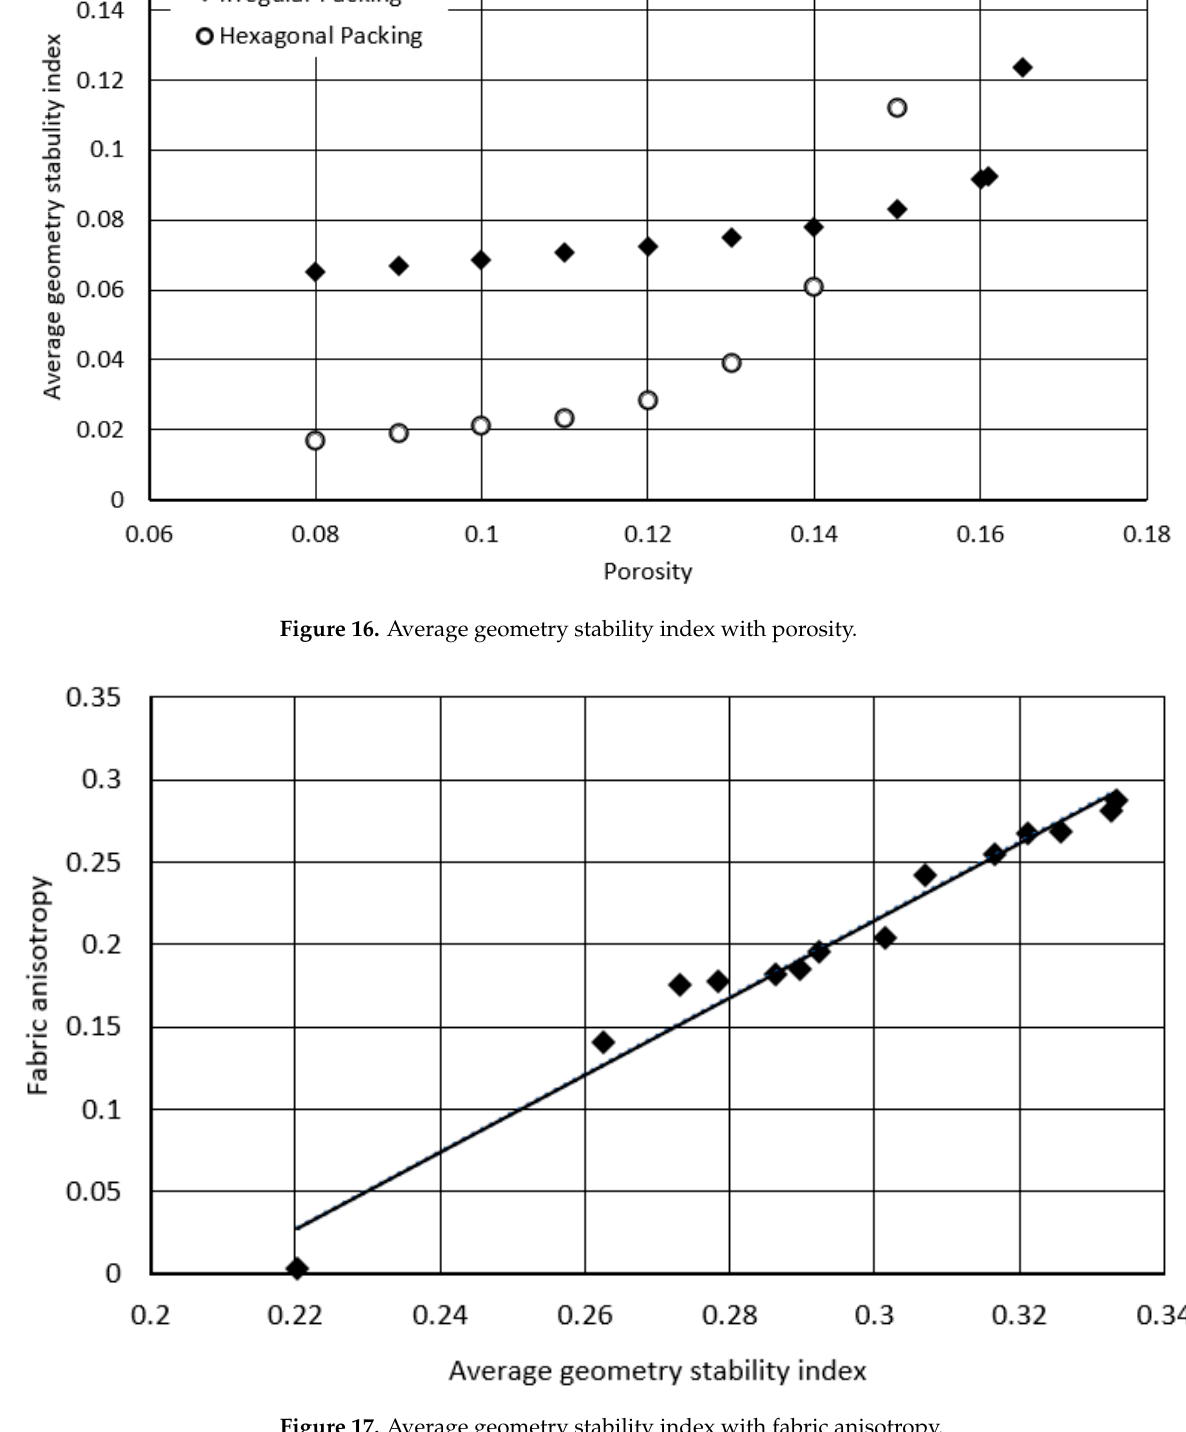
Figure 16. Average geometry stability index with porosity.